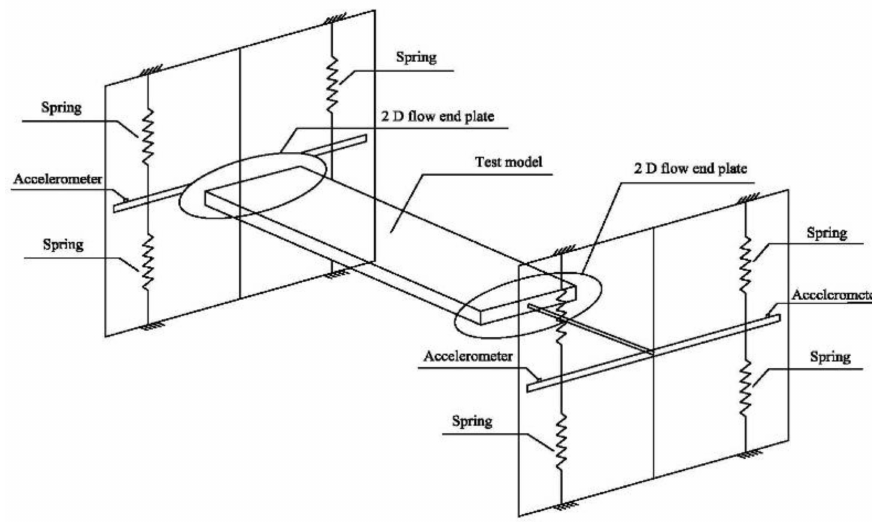
Figure 4. Sketch of the model vibration measurement system.